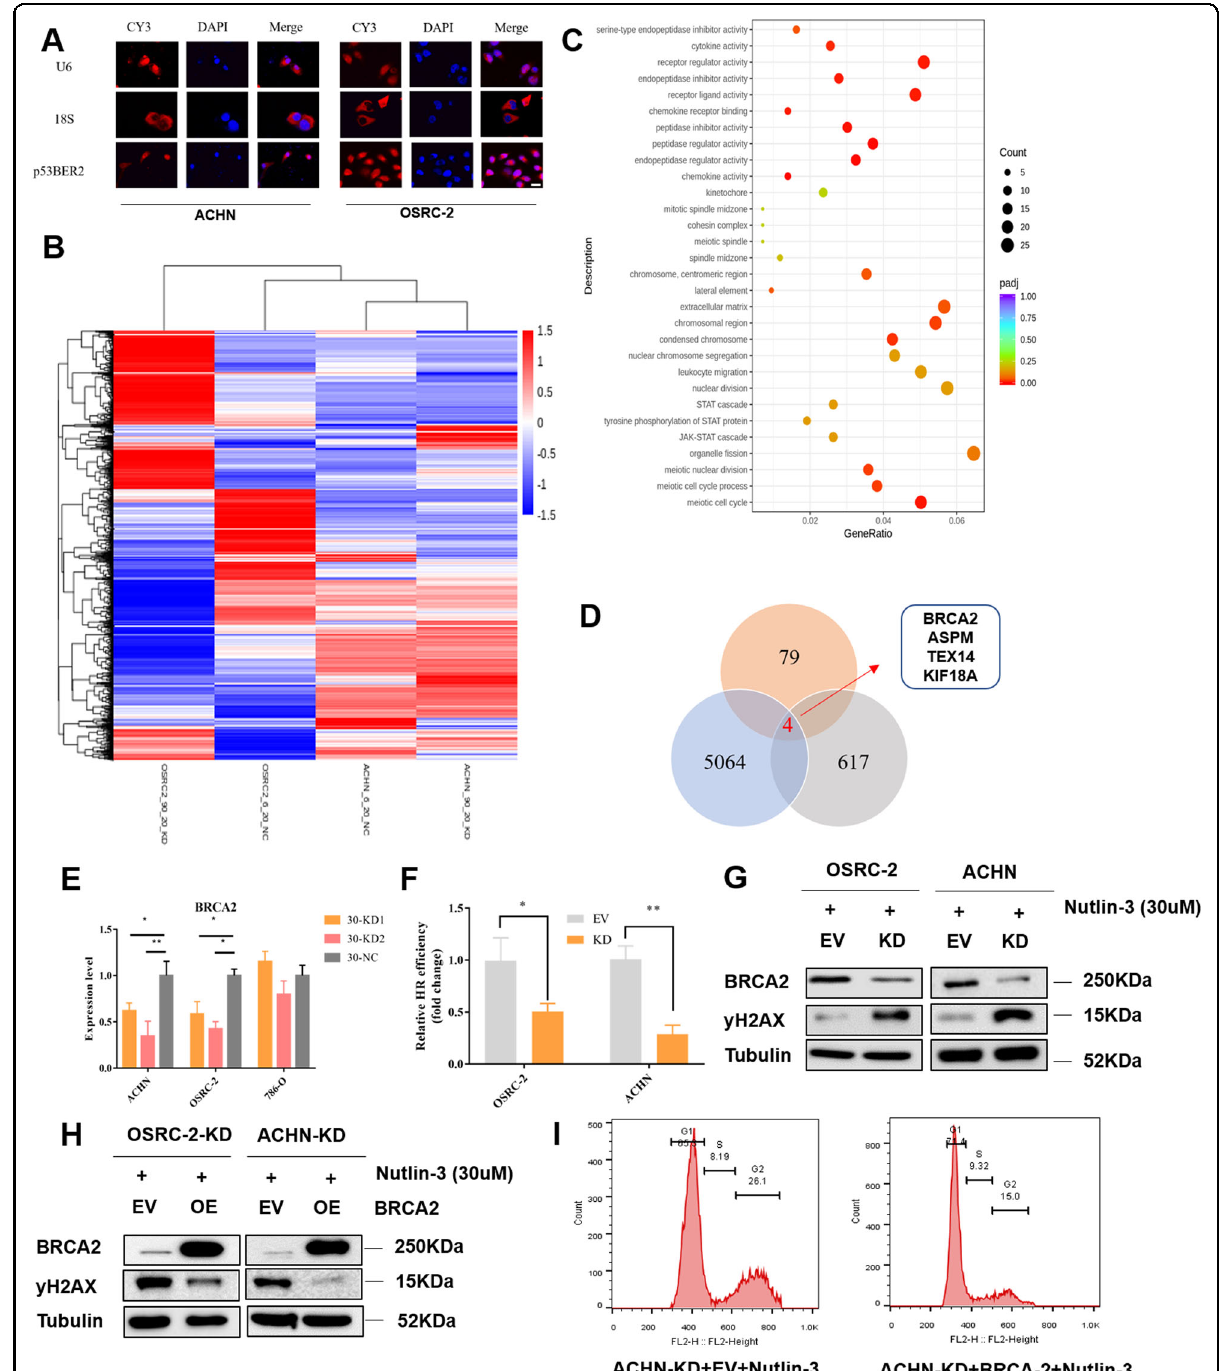
Fig. 5 P53BER2 positively regulates cell cycle and DNA repair by mediating BRCA2. A The location of p53BER2 in RCC cell lines with confocal image, scale bar, 20 μ m. B Heatmap representation of differentially expressed genes identi fi ed by RNA-Seq between P53BER-KD group and control group. C The Go terms enriched analysis of different biological processes in p53-KD and NC RCC line by RNA-sequencing. D Overlap of the differential genes of the two cell lines and the differential genes related to the cell-cycle pathway. E The BRCA2 expression level of different RCC cell lines infected p53BER2-KD virus and vectors after nutlin-3 treatment(30uM). F HR ef fi ciency of ACHN and OSRC-2 after p53BER2 knockdown. G Western blot of yH2AX in p53BER2-KD and control cells after nutlin-3 treatments (30 μ M). H Western blot of OSRC-2 and ACHN cells after transfected with BRCA2. I The proportion of cell cycle of ACHN-KD transfected BRCA2 after nutlin-3 treatment (30 μ M). EV empty vector, KD p53BER2 knockdown, OE overexpression. Results are shown as mean ± SD. *** P < 0.001 compared with control. ** P < 0.01 compared with control. * P < 0.05 compared with